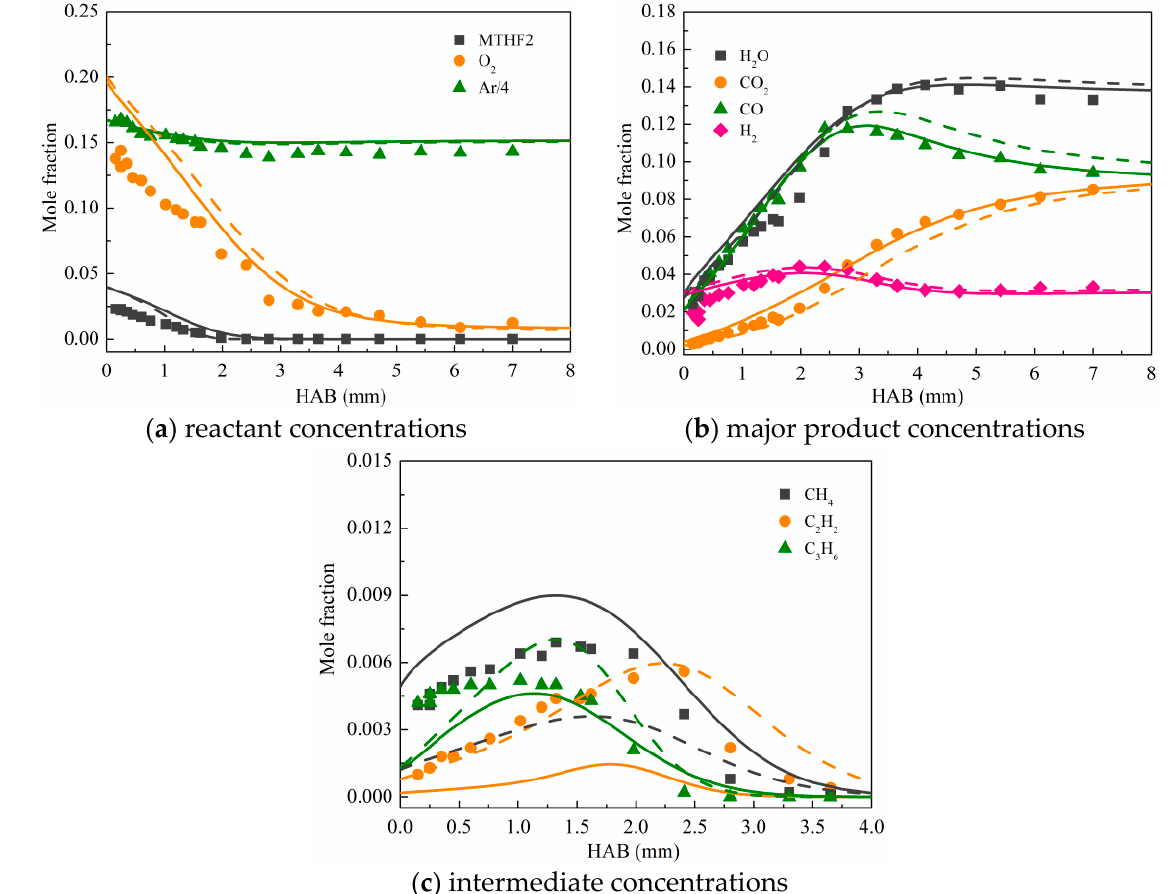
Figure 12. Measured (symbols) [16] and calculated (lines) species concentrations in premixed MTHF2 flames at φ = 1.3. Solid lines: reduced diesel/MTHF2 mechanism; dashed lines: detailed MTHF2 mechanism [17].